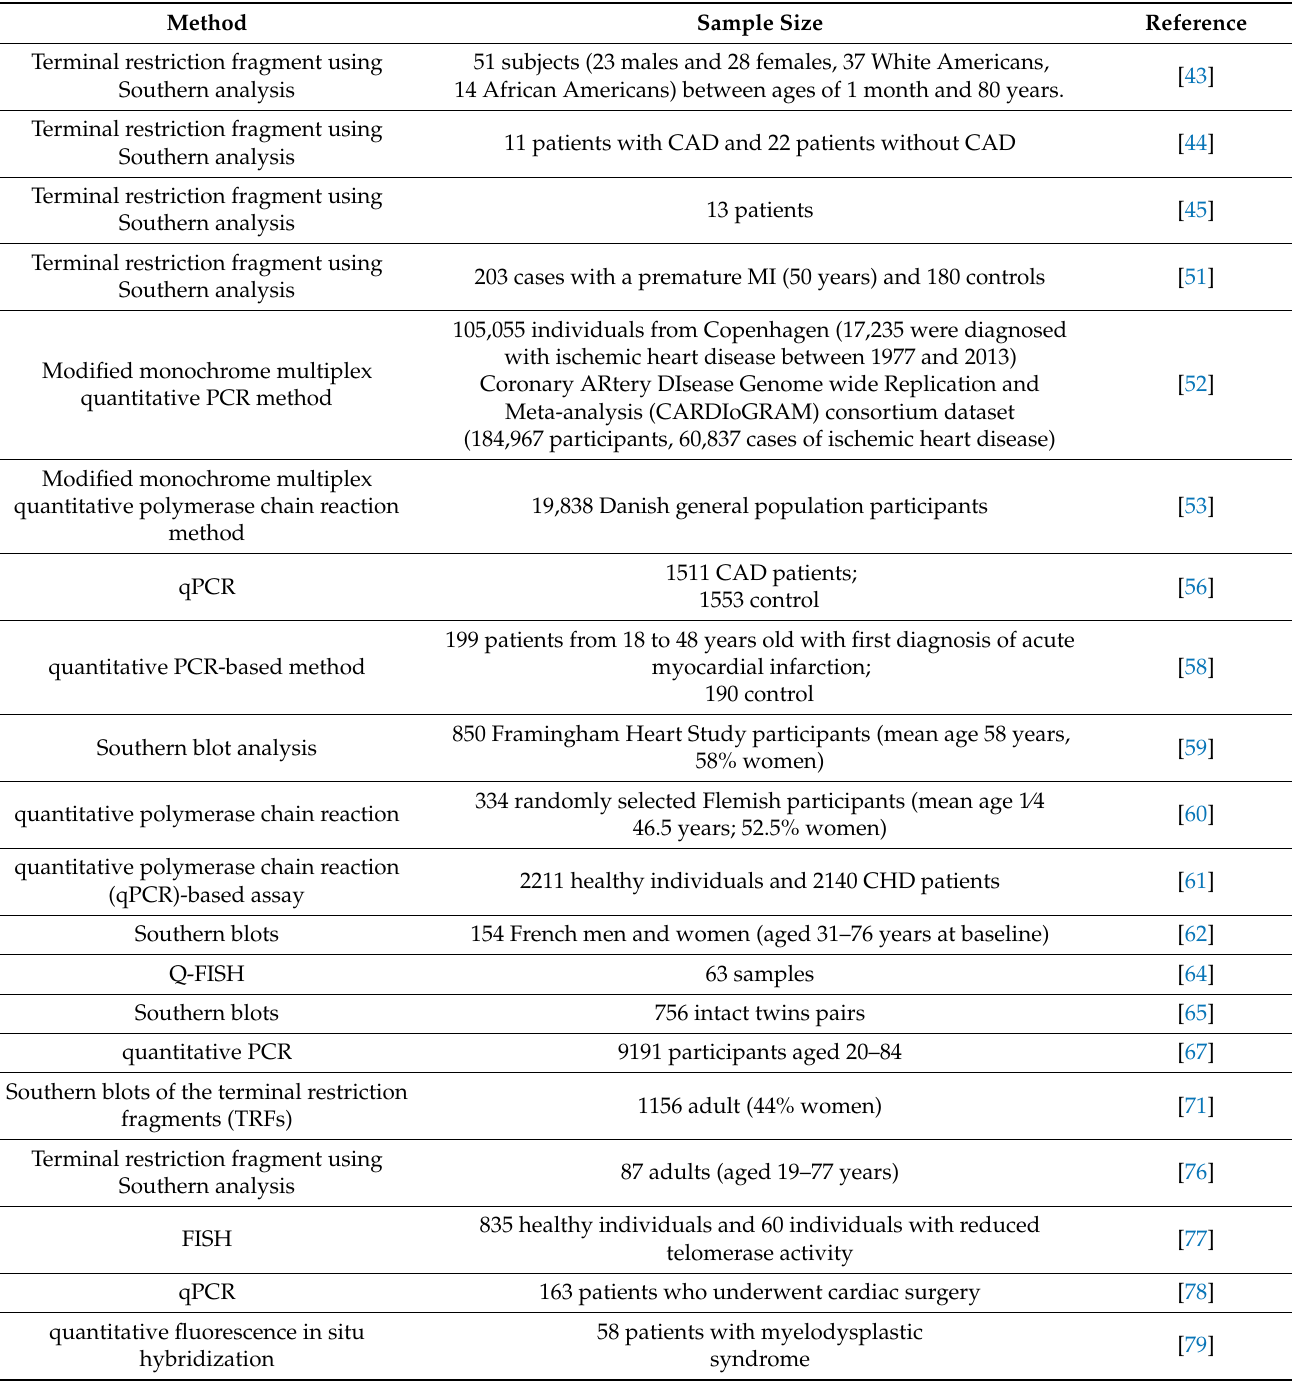
Table 1. Details of telomeres